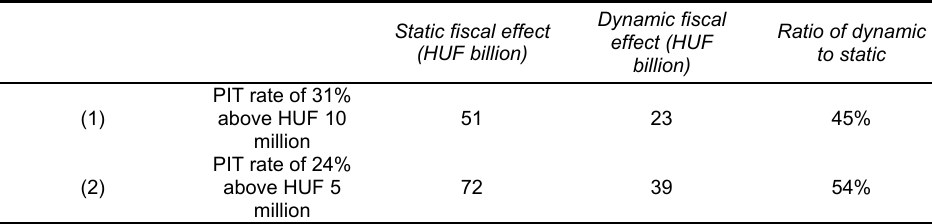
Table 4: Hypothetical tax policy